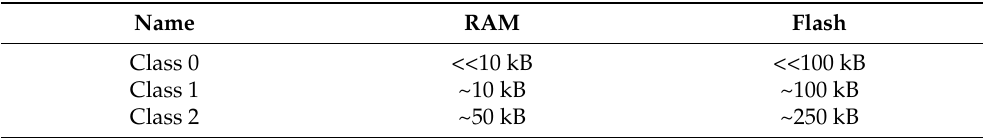
Table 1. Classes of Constrained IoT devices